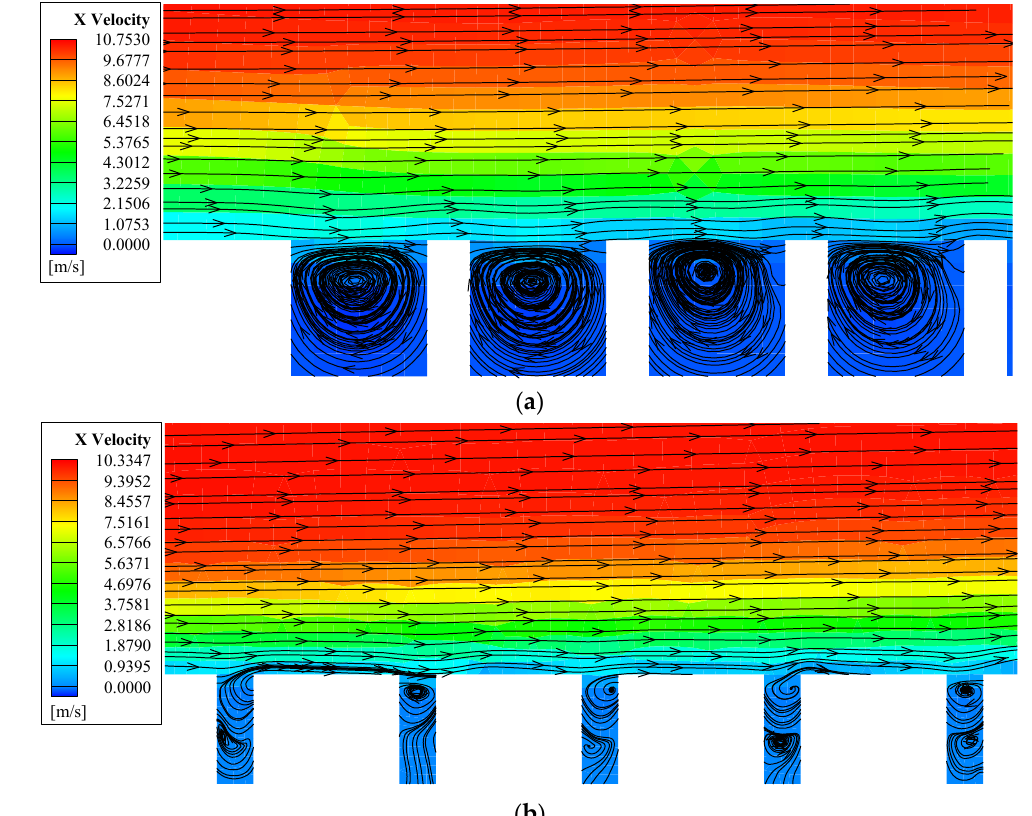
Figure 4. The velocity streamlines of various slip surfaces. ( a ) θ r = 154°; ( b ) θ r = 84°.